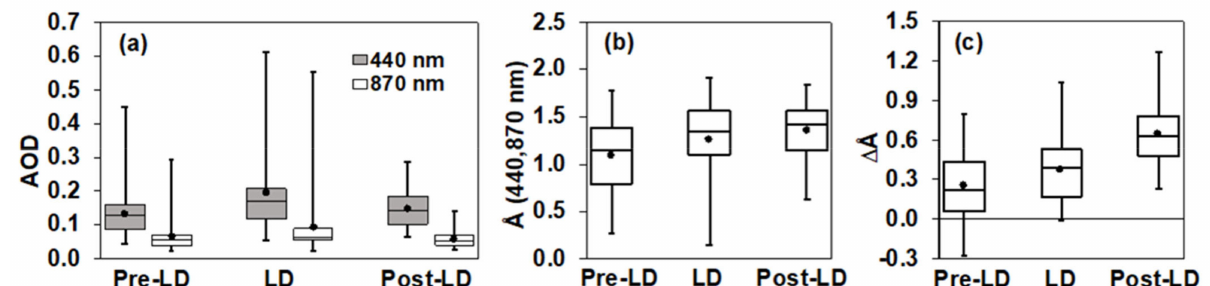
Figure 2. Box plots of the ( a ) Aerosol Optical Depth AOD at 440 nm (grey boxes) and 870 nm (white boxes), ( b ) Ångström Exponent Å at the wavelength pair 440–870 nm, and ( c ) Ångström Exponent difference ∆ Å in Pre-LD (before lockdown), LD (during lockdown), and Post-LD (after lockdown) periods. Horizontal lines and dots in each box are the median and mean values, respectively. The 25th and the 75th percentiles are indicated by the lower and upper boundaries of the box, respectively. The lower and upper whiskers represent the 5th and the 95th percentiles,